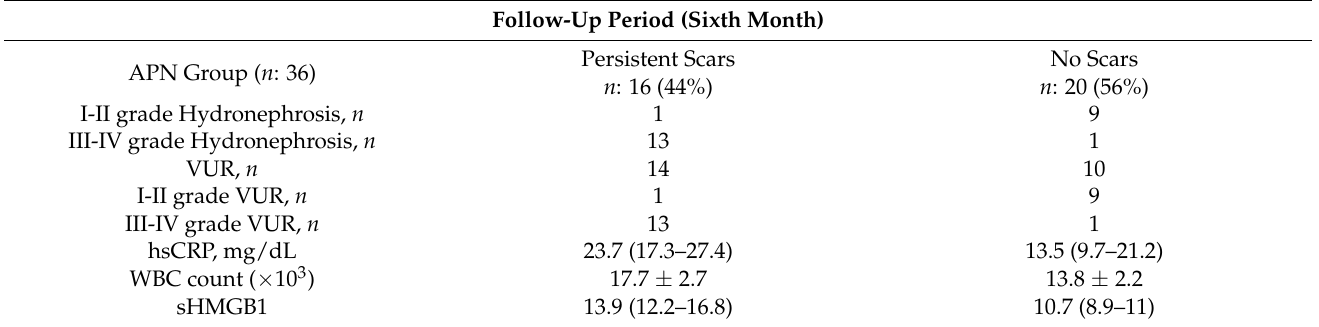
Table 3. Patients with Acute Pyelonephritis after the follow-up